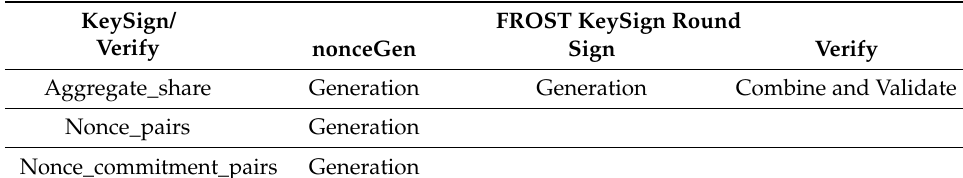
Table 2. Created items by key generation